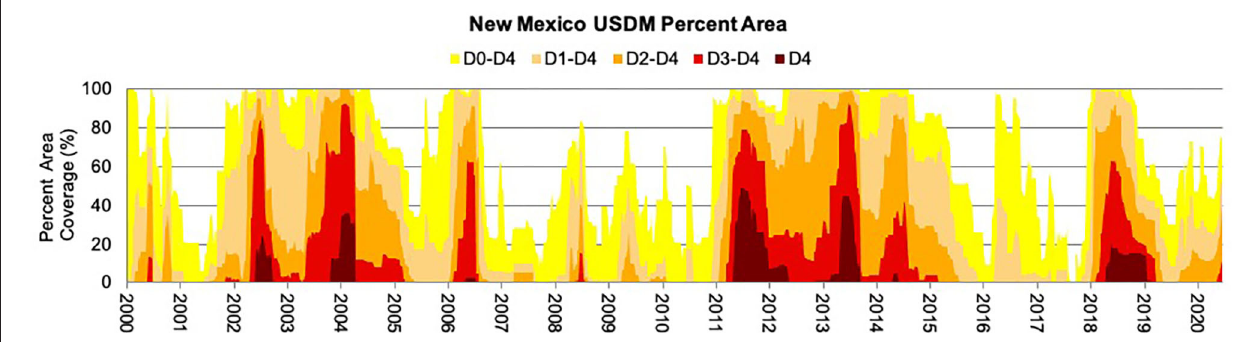
FIGURE 1 | A time series of the weekly percent area of the USDM spatial coverage by severity category across New Mexico for the 2000–2020 period (NDMC, 2020). The colors represent the five USDM drought categories.